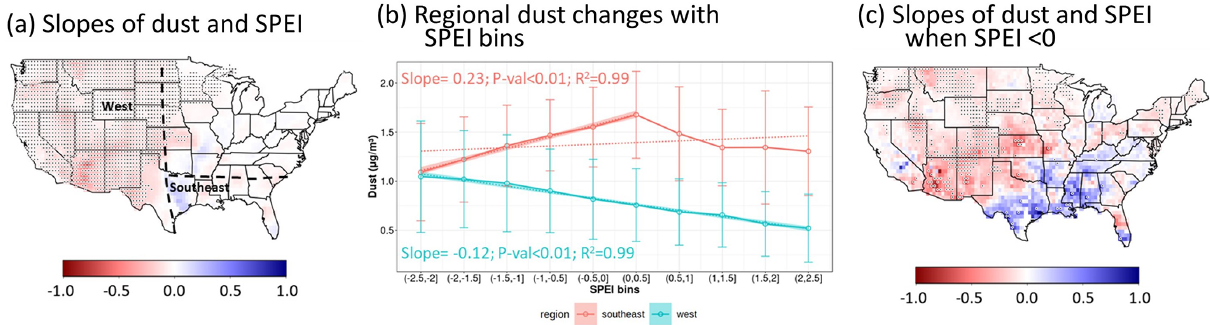
Figure 2. (a) Maps of the linear regression slopes between fine-dust concentrations and SPEI during 2000–2018 in JJA. Black dots denote the grids with regression significance at a 95% confidence level. Dashed lines mark the boundaries of the west and southeast regions. (b) Regional average dust changes with SPEI bins over the west and southeast with error bars indicating 1 standard deviation. Dashed lines display linear regression results with shading showing the 95% confidence level. The numbers indicate the slopes, P values ( P -val), and determination coefficient ( R 2 ) of the regression using all the SPEI bins in the west and only the first six bins in the southeast. (c) The same as (a) but using data under drought conditions (SPEI < 0)